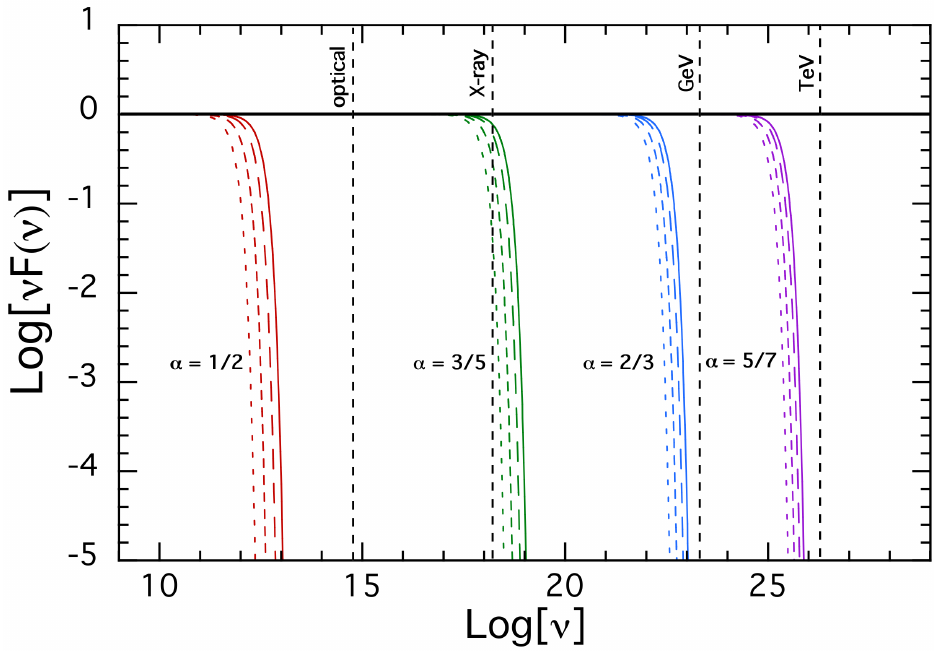
Figure 2. The relative observed flux density ν F ν , as a function of frequency ν . Curves are shown for comoving distances of 425 Mpc ( z ≈ 0.1; solid), 1 Gpc ( z ≈ 0.25; long-dashed), 3 Gpc ( z ≈ 1; medium-dashed) and 10 Gpc ( z ≈ 12; short-dashed). The plotted curves assume α = 1/2 (red), 3/5 (green), 2/3 (blue) and 5/7 (purple). They imply that for a given value of α , there will be a maximum frequency ν (or equivalently, a shortest wavelength λ ) beyond which a source would simply be undetectable, as the ensemble of photons received from the source would have a phase dispersion of ∆ φ ∼ 1 radian, making an image impossible to